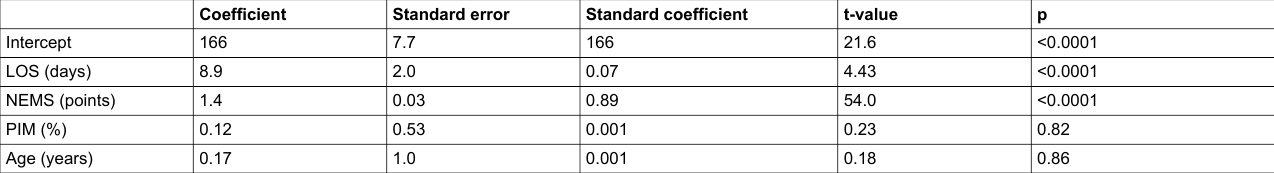
Table 4: Multiple regression analysis. Workload (min) is the dependent variable (n = 2,513). R squared for the whole regression is